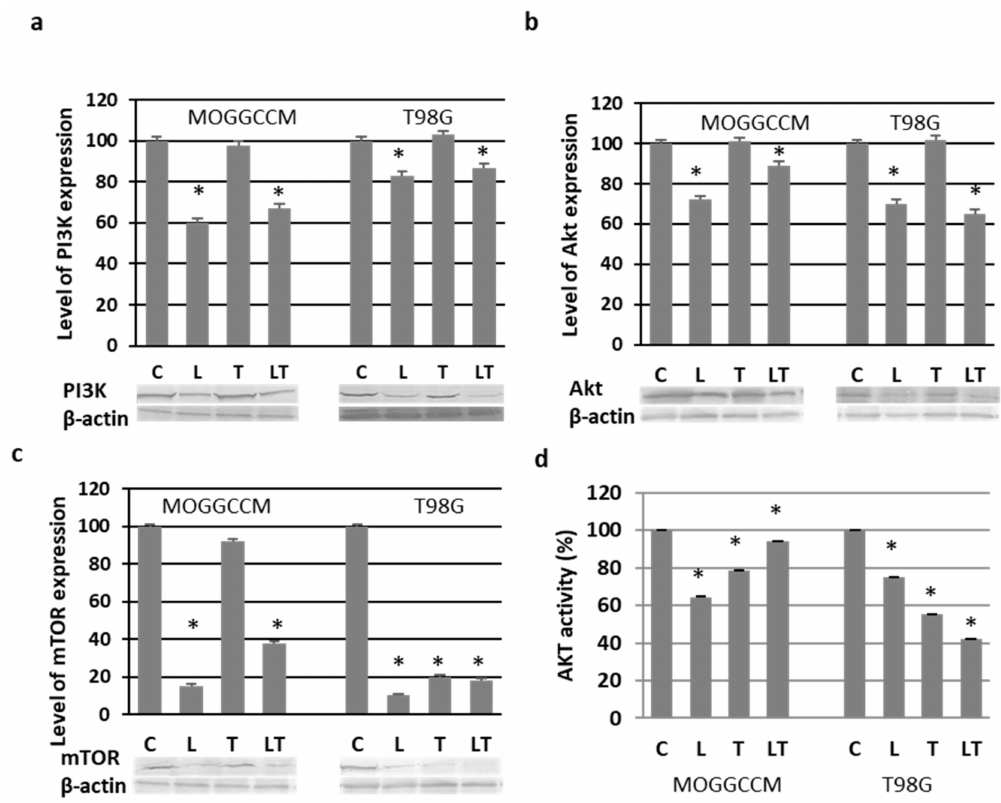
Figure 6. Levels of PI3K ( a ), Akt ( b ), and mTOR ( c ) with representative blots as well as Akt activity ( d ) in MOGGCCM and T98G cells after LY294002 (L) and temozolomide (T) incubation, applied alone or in combination (LT). C—control, * p < 0.01 compared to